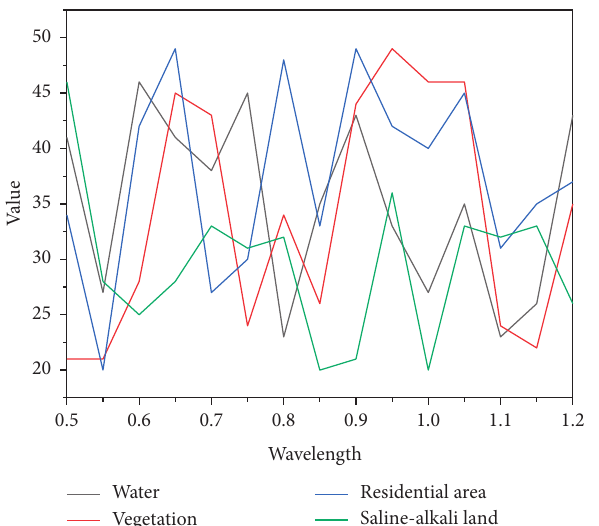
Figure 6: Spectral profile of the